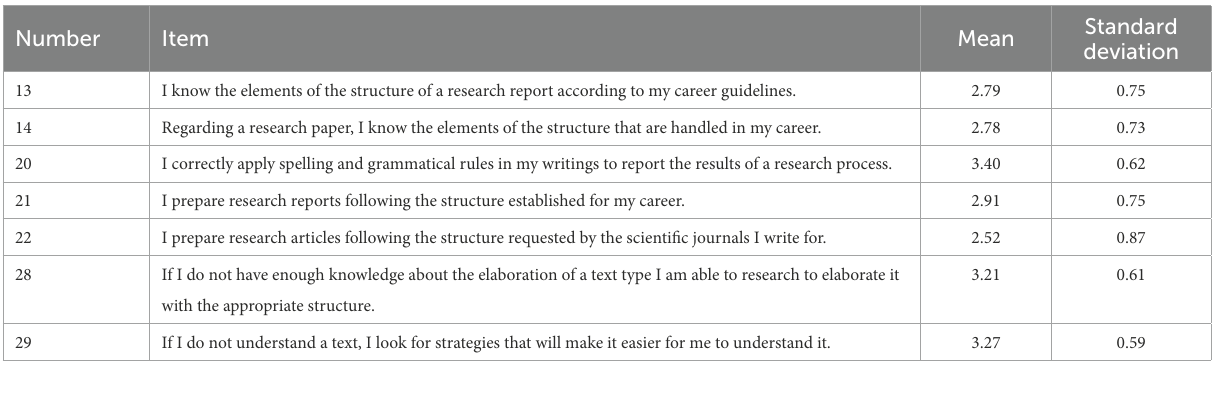
TABLE 5 Comparative analysis between Mexico and Spain.